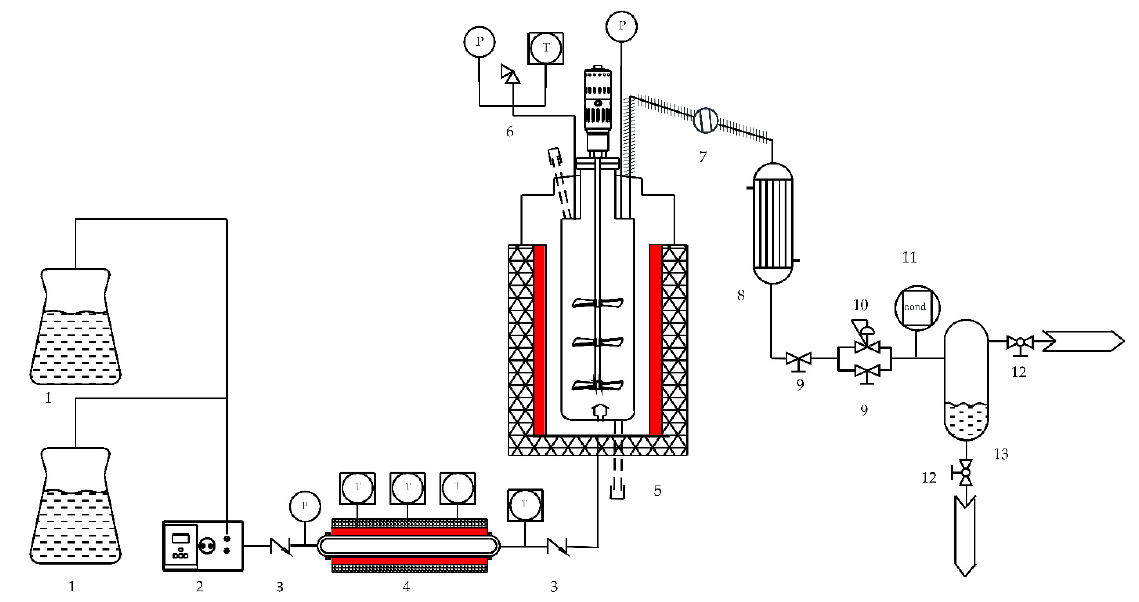
Figure 1. Flow chart of supercritical desalination device. 1, Tank; 2, high-pressure pump; 3, check valve; 4, preheater; 5, reactor with stirring device; 6, bursting disc; 7, filter; 8, condenser; 9, needle valve; 10, back pressure valve; 11, conductivity meter; 12, ball valve; 13, reservoir.